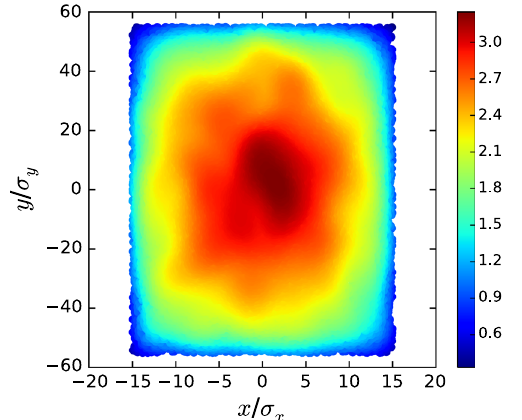
FIG. 14. Halo distribution after collimation to 15 σ x and 55 σ y at the entrance of the FFS.